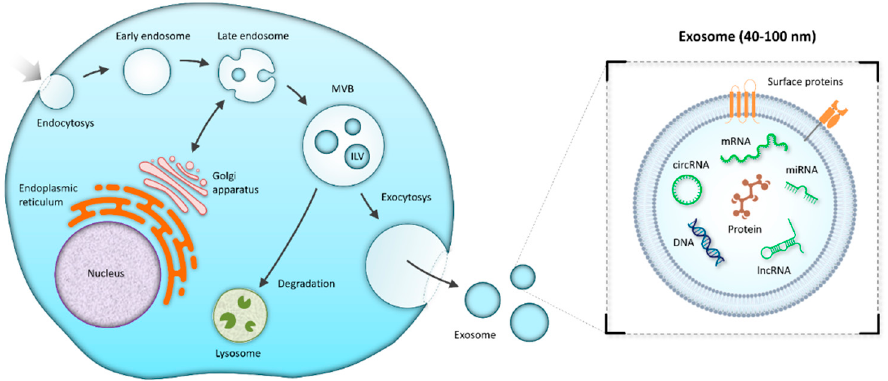
Figure 1. Exosome biogenesis. The process of endocytosis results in the formation of an early endosome, followed by a maturation to a late endosome that may bidirectionally exchange vesicles with the Golgi apparatus and the endoplasmic reticulum. Invagination of late endosomal membranes forms the intraluminal vesicles (ILVs) contained in the multivesicular body (MVB). The MVB may fuse with the plasma membrane and release ILVs to the extracellular space as exosomes. On the other hand, the MVB may also be transported to a lysosome for subsequent degradation of its content.